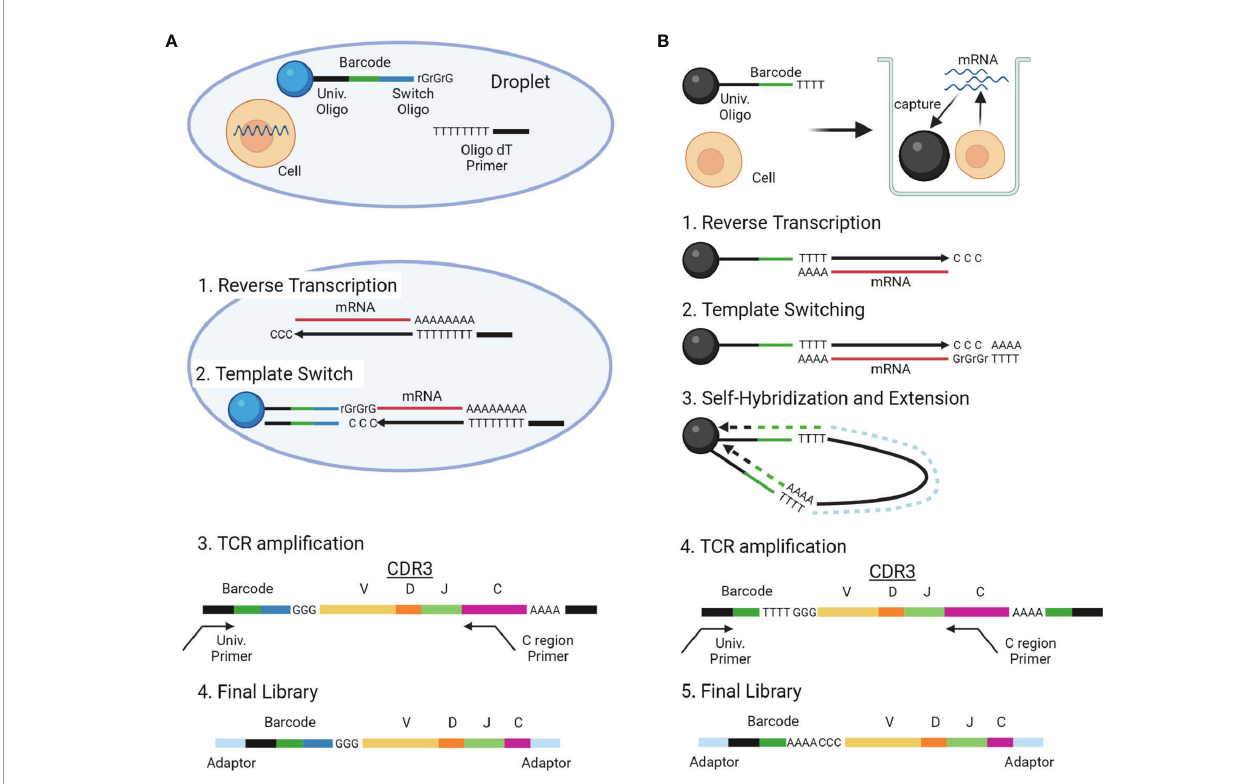
FIGURE 3 | Overview of scTCRseq methods. (A) Overview of the scTCRseq method using 5 ′ RNA ampli fi cation. Cells are isolated in oil-in-water droplets. After cell lysis, mRNAs from a single cell are reverse-transcribed using oligo-dT primers. An adapter containing a cellular barcode and a universal oligo is added at the 5 ′ end of cDNA by template switching. TCR transcripts containing CDR3 and the cellular barcode are speci fi cally ampli fi ed using primers designed to target the TCR C region and the universal oligo. The ampli fi ed TCRs are sequenced using NGS. (B) Overview of the scTCRseq method using self-hybridization. Single cells and beads with cellular barcodes are loaded into micro-wells. After cell lysis, mRNAs from the single cells are captured by the oligo-dT sequences on the beads. After reverse transcription, a synthetic poly-A tail is added to the 3 ′ end of the cDNA by template switching. Through denaturation and annealing, the synthetic poly-A tail at the 3 ′ end of the cDNA hybridizes to the oligo-dT sequence on its own bead. The second strand of cDNA is then stretched by DNA polymerase to copy the cellular barcode of the bead. TCR transcripts containing CDR3 and a cellular barcode are speci fi cally ampli fi ed using primers designed to target the TCR C region and the universal oligo. The ampli fi ed TCRs are sequenced using NGS.